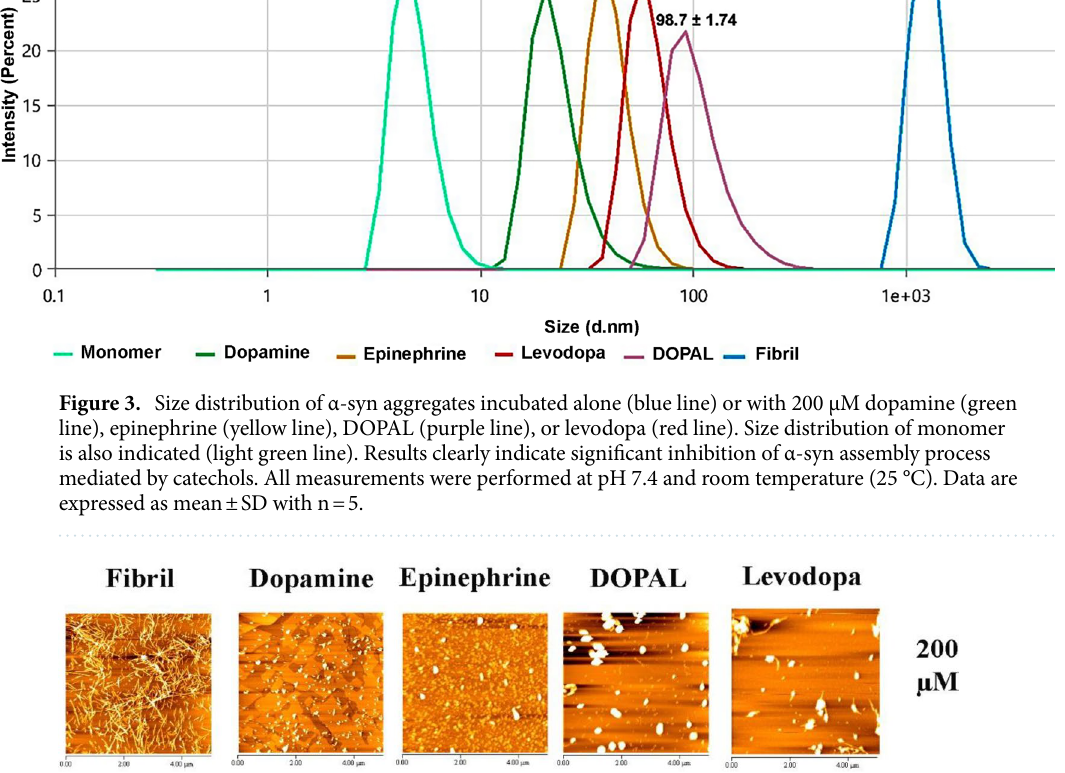
Fig. S9, exposure of SH-SY5Y cells to 20 µM α-syn fibrils resulted in a significant enhancement in intracellular ROS content and a considerable loss of mitochondrial membrane potential evaluated by DCFDA and rhoda-